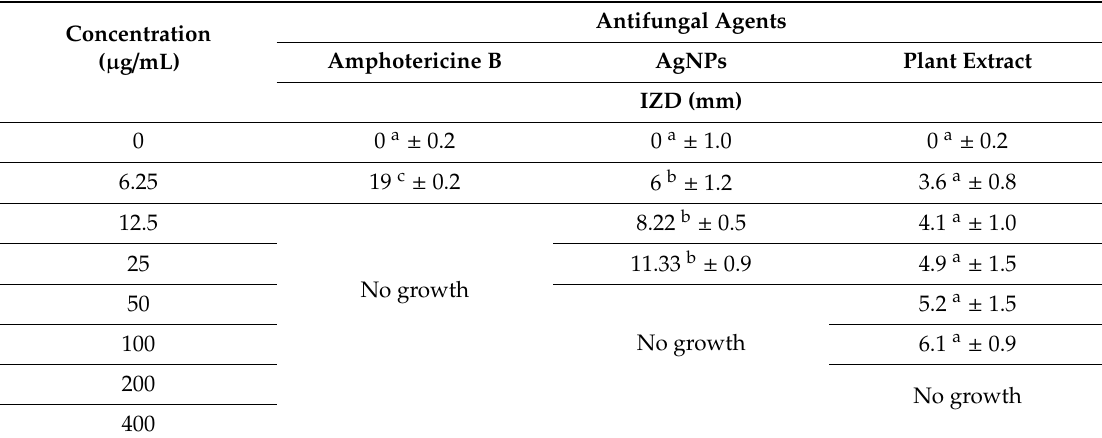
Table 1. Anti-candidal activity of AgNPs and plant extract against C. albicans. Concentration